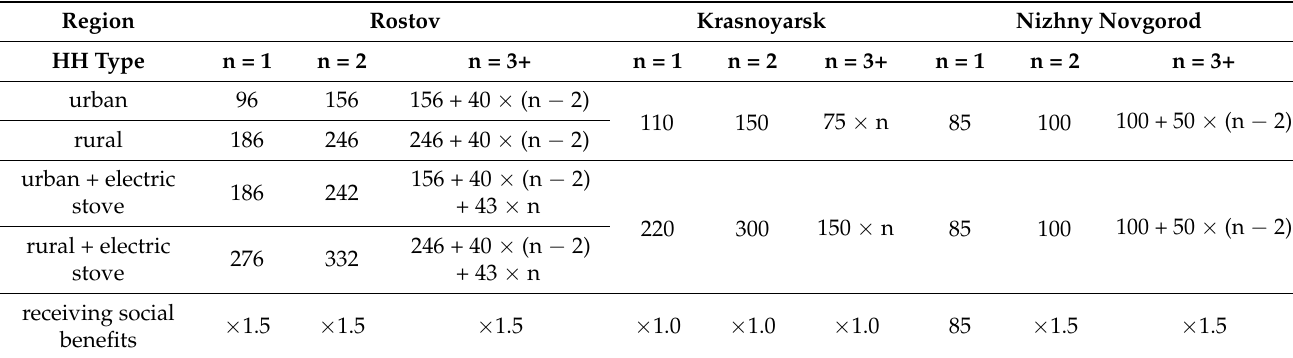
Table 1. Prescribed Social Norm for Electricity